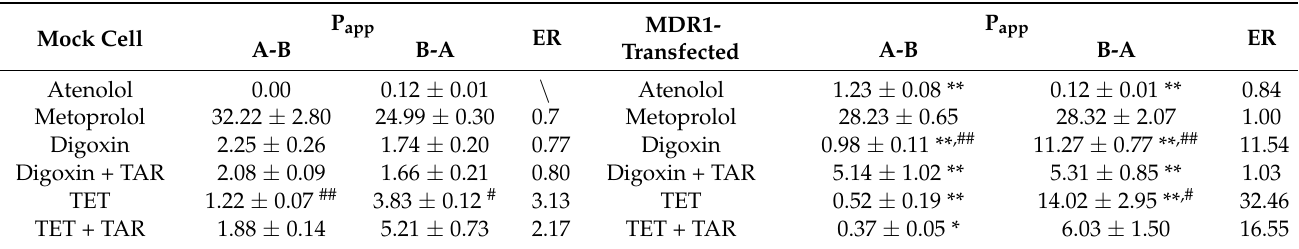
Table 5. The bidirectional transport of TET in MOCK and MDR1-transfected LLC-PK1 cells ( n = 3, Mean ±